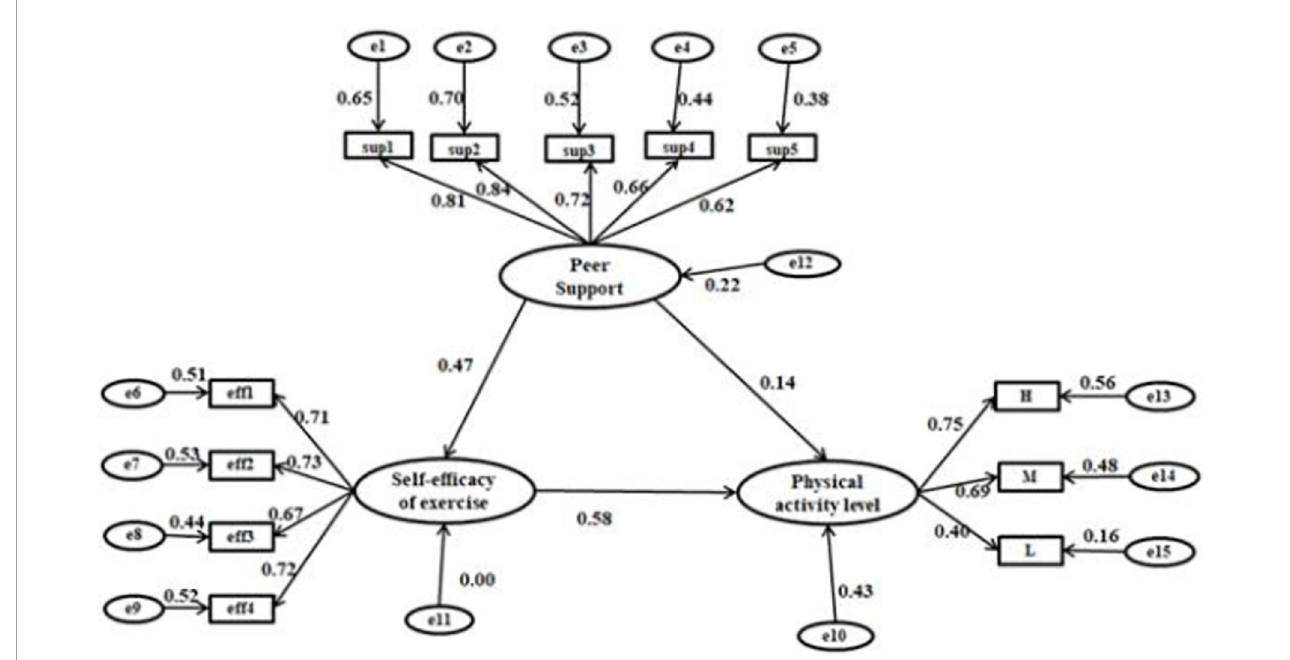
FIGURE2 The overall structural equation model. Model–fit indices were statistically acceptable (CMID/DF = 2.778, GFI = 0.926, AGFI = 0.892, RMSEA = 0.073, p = 0.001, CFI = 0.926, IFI = 0.906).